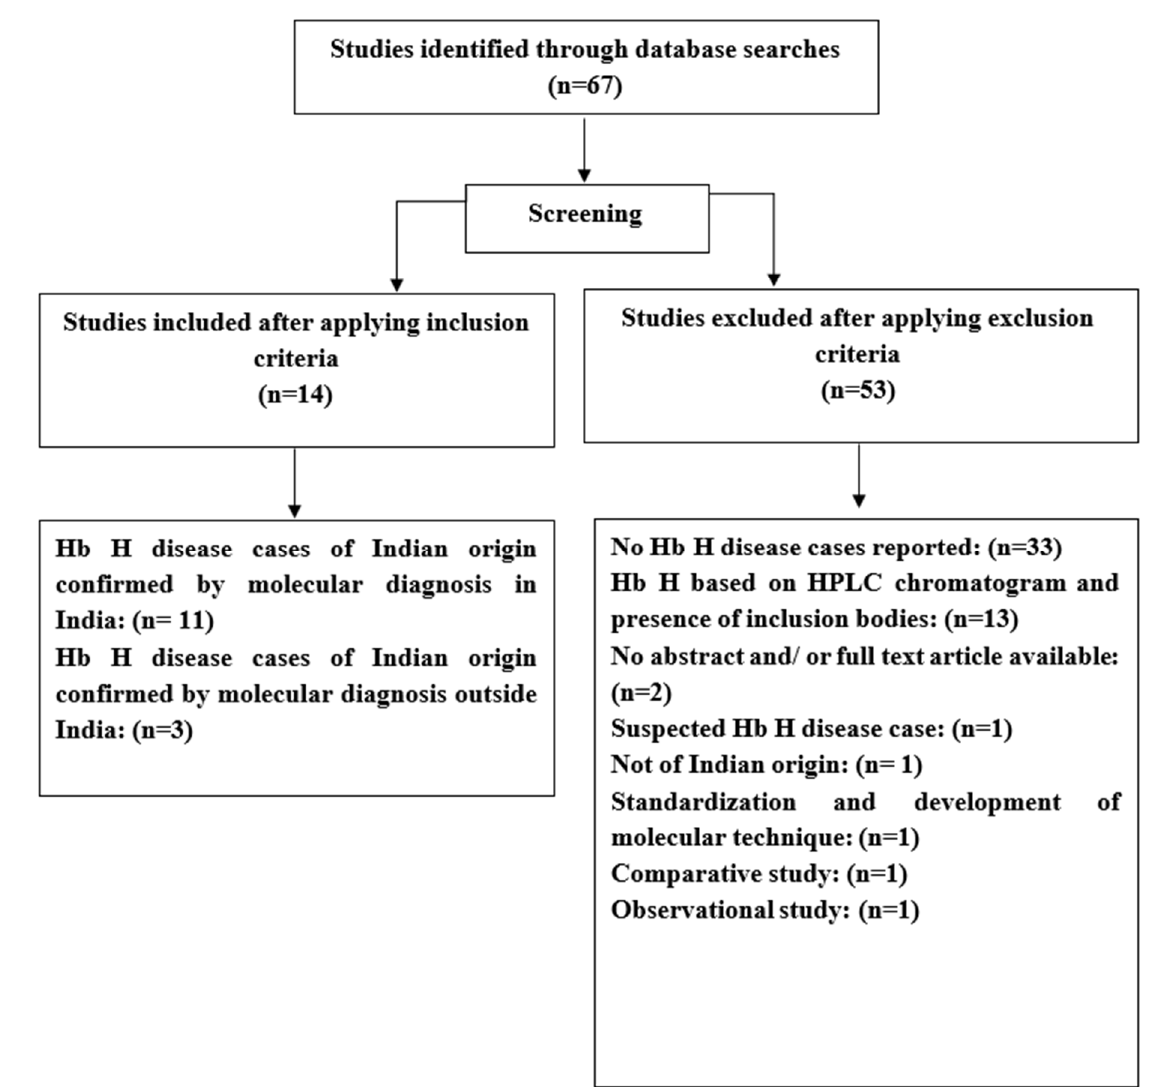
Figure 1. PRISMA flow diagram of the literature search. The commonest genotypes causing Hb H disease in Indians were - α 3.7 /– SA and - α 4.2 /– SA reported from different states (Table 1). Sarkar et al. reported a novel 33.3 kb deletion (– KOL ) in 3 cases originating from the north eastern region of India. One of them presented clinically with hypochromic microcytic anemia, having recurrent jaundice in the past, mild icterus, a palpable and enlarged liver and spleen and was diagnosed as a case of Hb H disease with the – α 3.7 /– KOL genotype. In the other two cases having unexplained anemia, the mutation was reported to be αα /– KOL by using multiplex GAP PCR analysis; however, the other mutation remained uncharacterized [13]. Nadkarni et al. [14] reported 8 Hb H disease cases referred from different regions of India. The mutations identified were - α 3.7 /– SA in 3, - α 3.7 /– SEA in 2, - α 3.7 /- α 3.7+HbSallanches in 1 and – SA /– α 3.7+HbSallanches in two Hb H disease cases. All these cases had hypochromic microcytic anemia with mild splenomegaly. Most of them (6/8) had pallor, and four had jaundice. None of them had any history of blood